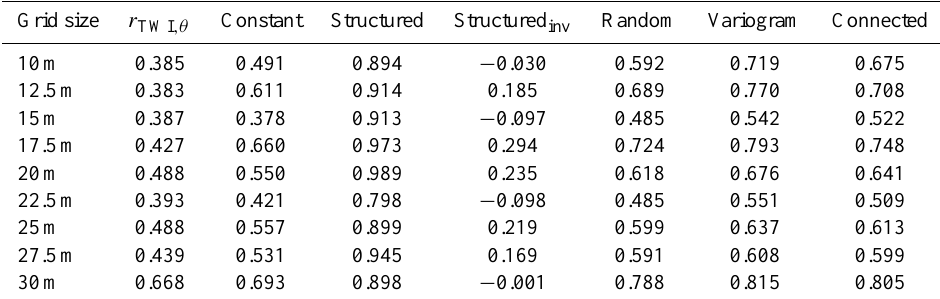
Table 5. Nash-Sutcliffe efficiency coefficients of the different scenarios of antecedent soil moisture maps compared to the Reference scenario for Marbaix, 15 April 2010 for varying grid sizes. The coefficients of correlation between the TWI and soil moisture ( r TWI ,θ ) are presented in the second